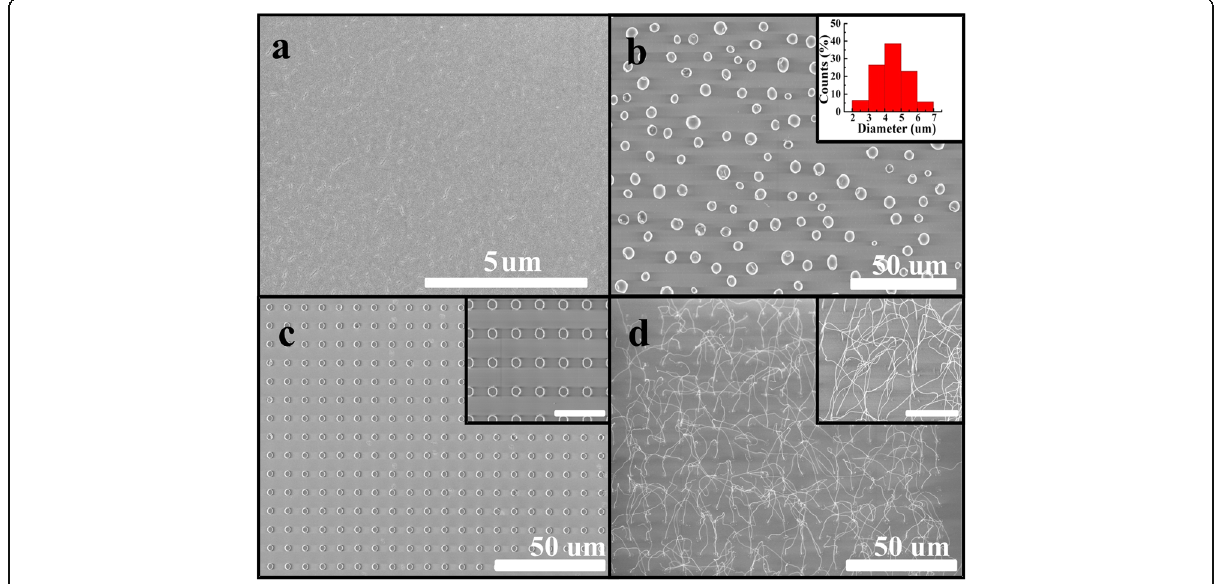
Fig. 3 SEM images for the two samples on 300 nm SiO 2 surface before and after 30 min annealed in Ar/H 2 atmosphere at temperature of 1080 °C. a Pre-annealed SEM image of sample I with Cu nanofilm (400 nm thick). b SEM images of sample I with Cu film after annealed. Inset photo was the diameter distribution of the Cu particles after SEM. c Pre-annealed SEM image of sample II with Cu patterns array (Cu pattern size, 400-nm thick and 1.9 μ m diameter). Inset photo was the magnified image of Cu patterns array. d SEM image of nanowire growth on sample II after annealed. Inset photo was the magnified image of nanowires. The scale bars in the insets are 10 μ